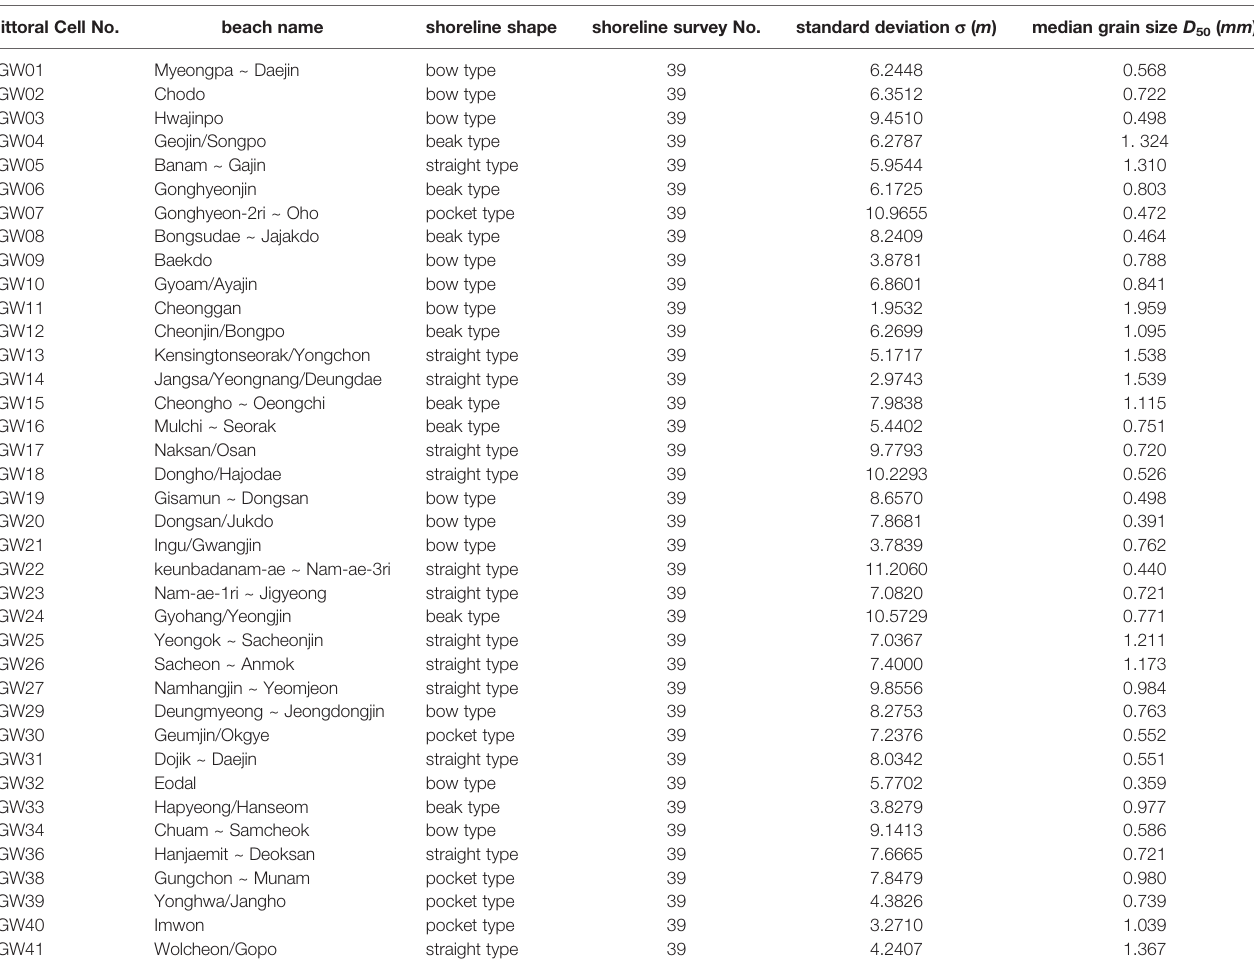
TABLE 2 | Basic information of littoral cells in Gangwon-do (The province of Gangwon, 2020 ). littoral Cell